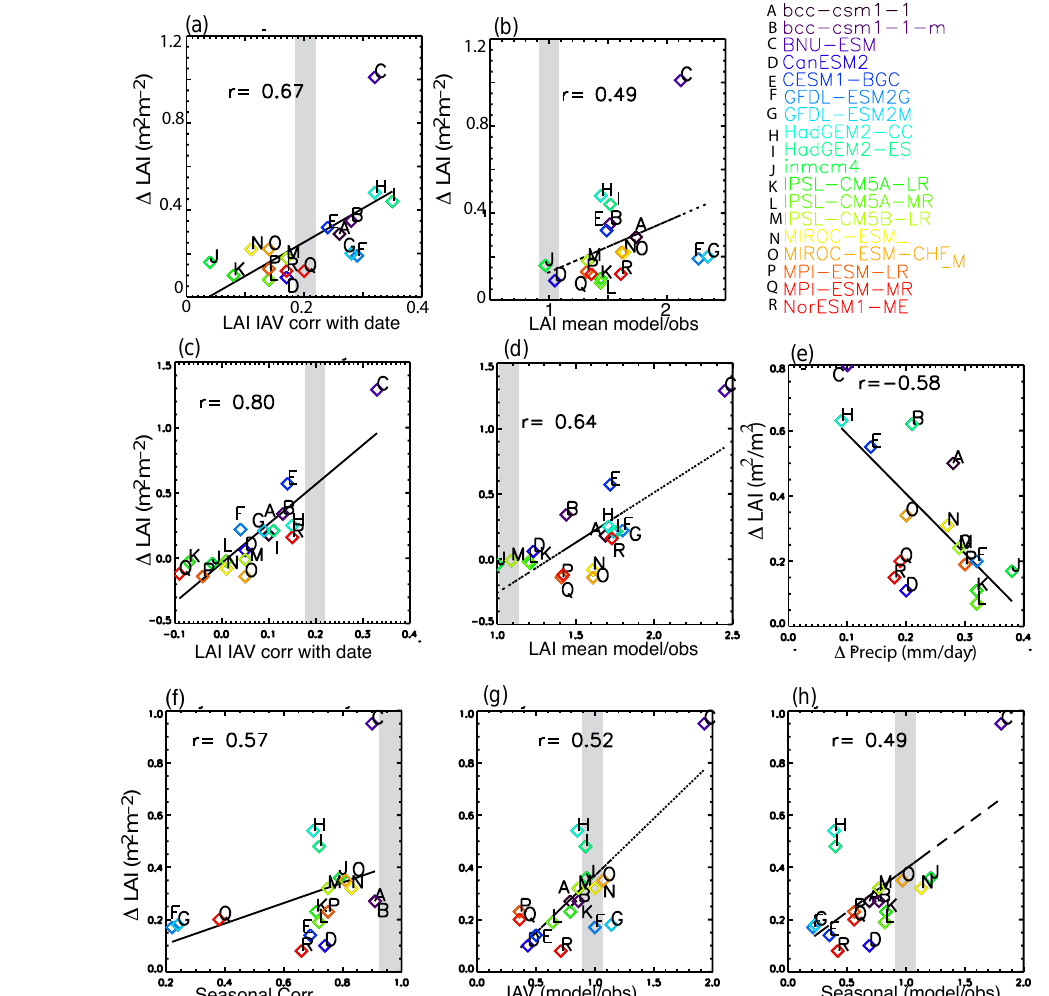
Figure 10. Scatterplot of the metrics with the highest absolute value of the correlation between the metric and future LAI changes across the globe (LAI IAV correlated with date (a) and mean LAI model/obs (b) tropics ( < 30 ◦ ) (LAI IAV correlated with date (c) and mean LAI model/obs d ), mid-latitudes (between 30 ◦ and 50 ◦ ) projected change in precipitation (e) and high-latitudes ( > 50 ◦ ) seasonal cycle average correlation (f) , strength of IAV model/obs (g) , and seasonal cycle strength model/obs (h) . The symbols are in the shown colors for each model. The gray represents the value an ideal model would have based on the observations. The black line is the line that results from a linear regression of the x and y